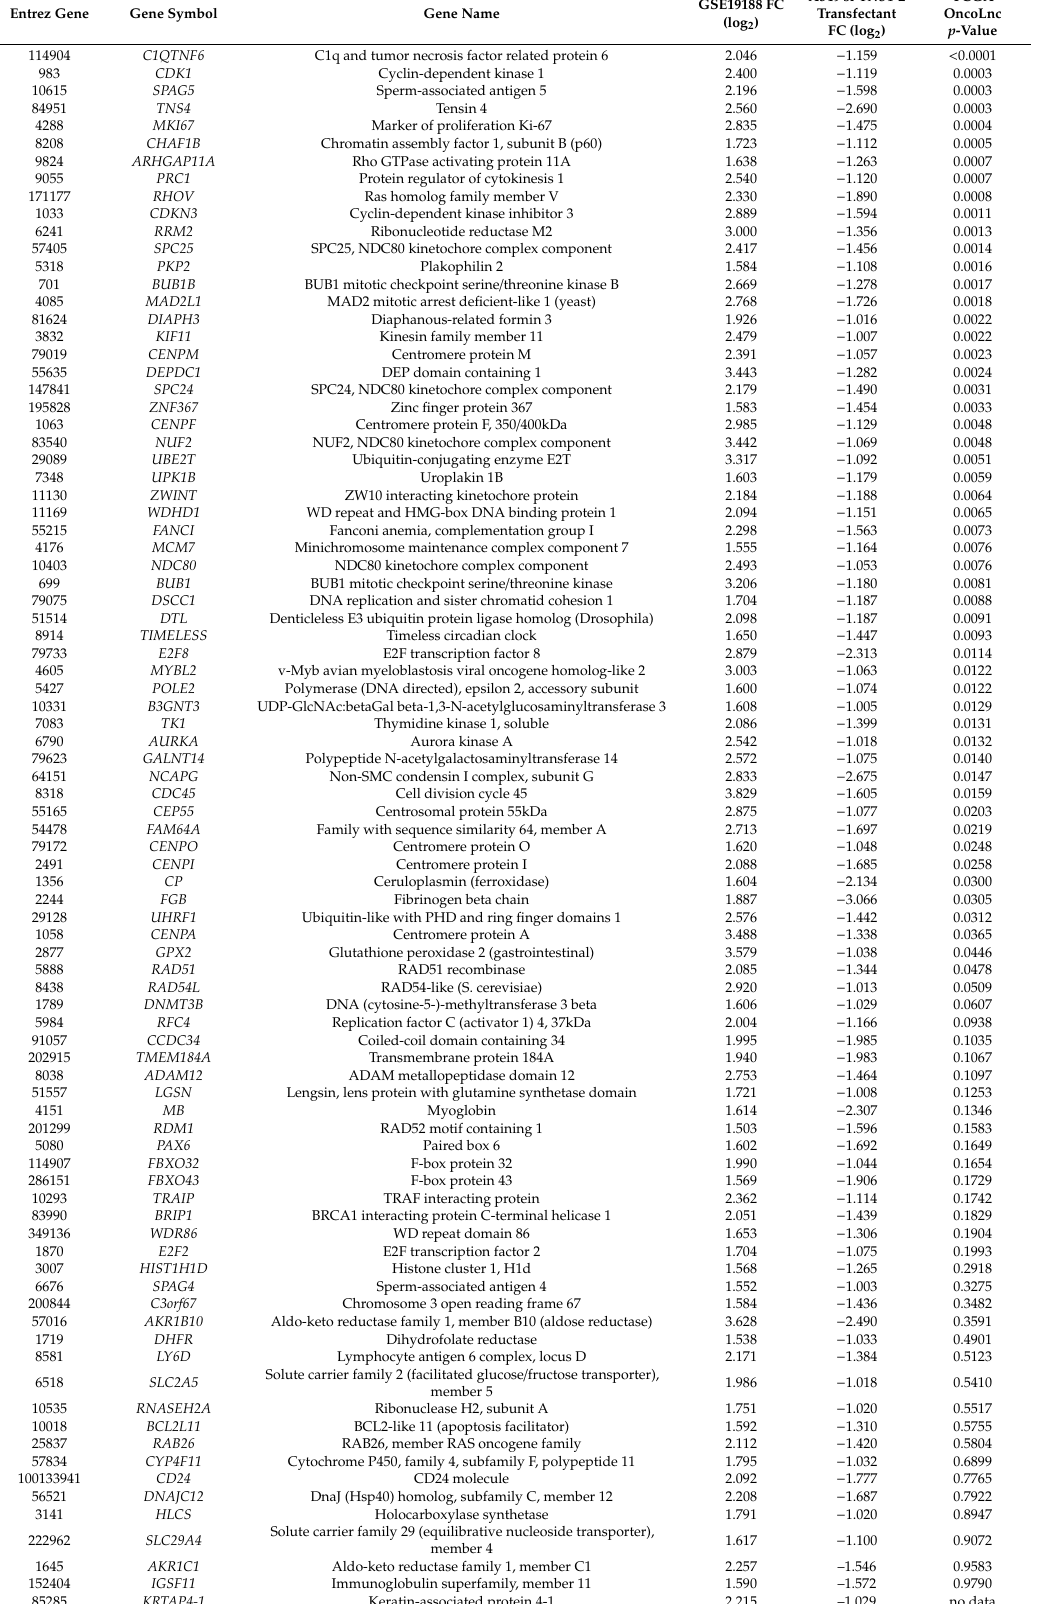
Table 4. Candidate downstream genes modulated by TNS4 in lung